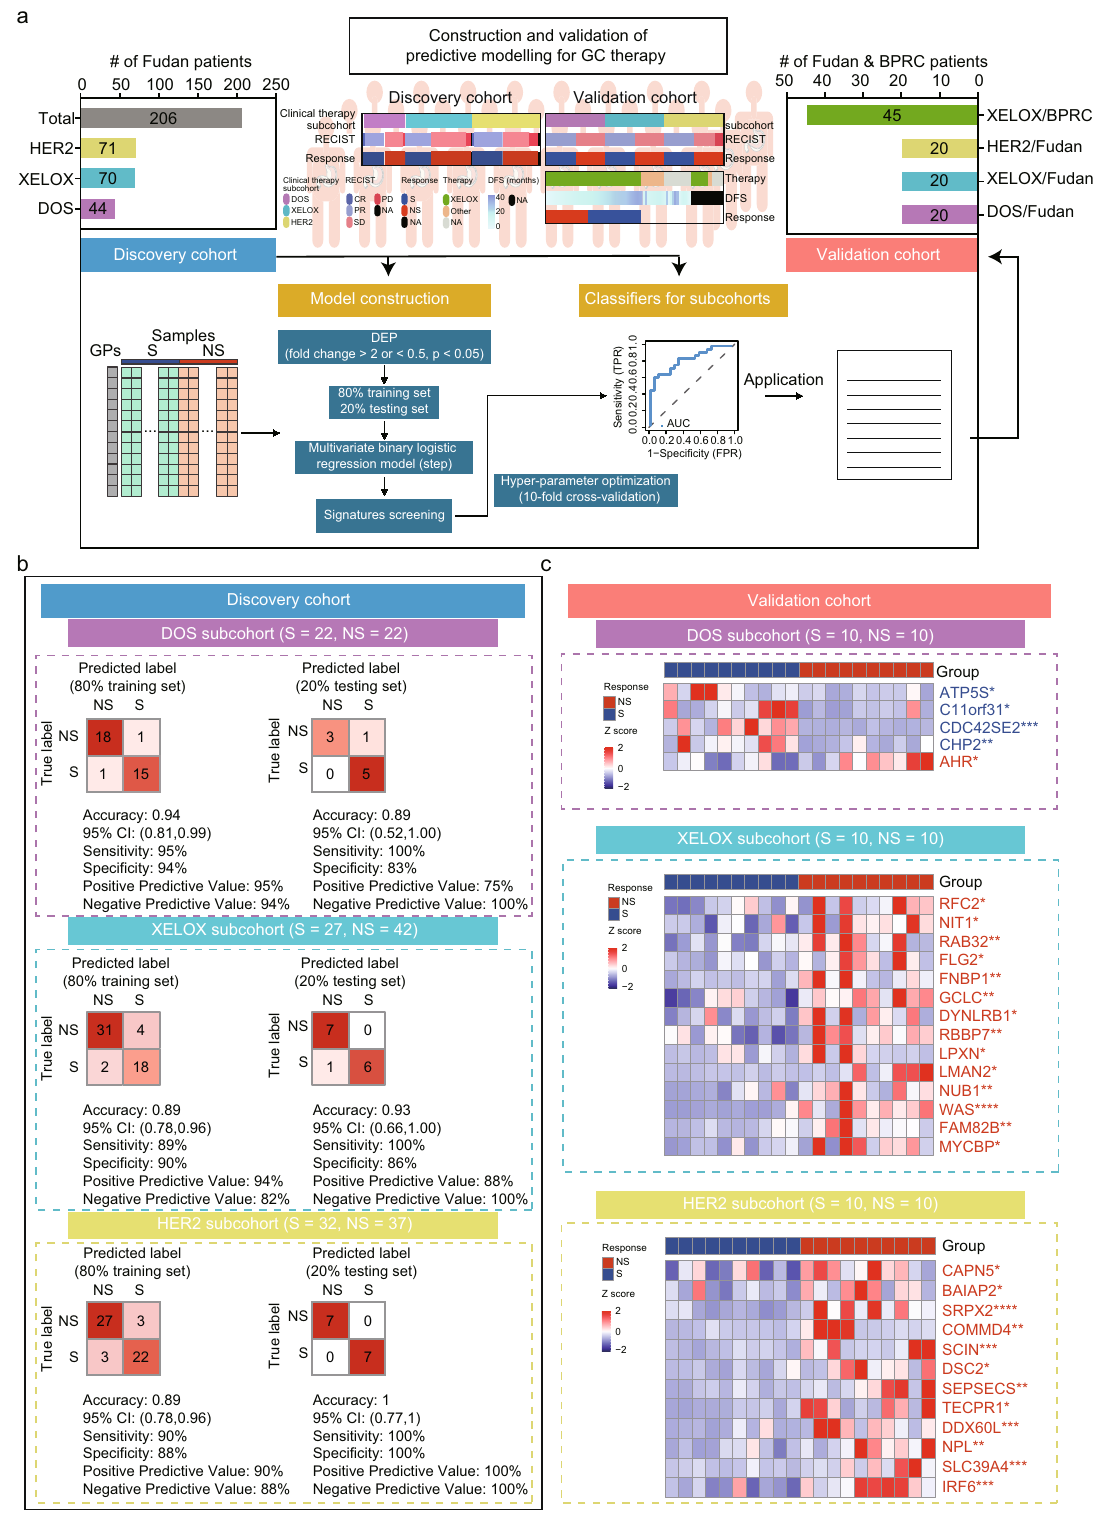
Fig. 6 | The construction and validation of predictive classi fi ers. a Diagram describingaconstructionandvalidationofthepredictivemodelingforsensitive(S) and non-sensitive (NS) groups. b The discovery cohort: Classi fi cation error matrix using logistic regression classi fi er of 80% training set and 20% testing set in DOS, XELOX, and HER2 subcohorts. The number of samples identi fi ed is noted in each